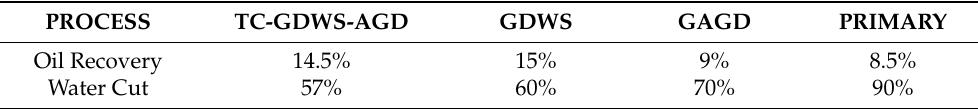
Table 3. Oil recovery and water cut after twelve years of production for the TC-GDWS-AGD, GDWS- AGD, GAGD, and primary (base-case) PUNQ-S3